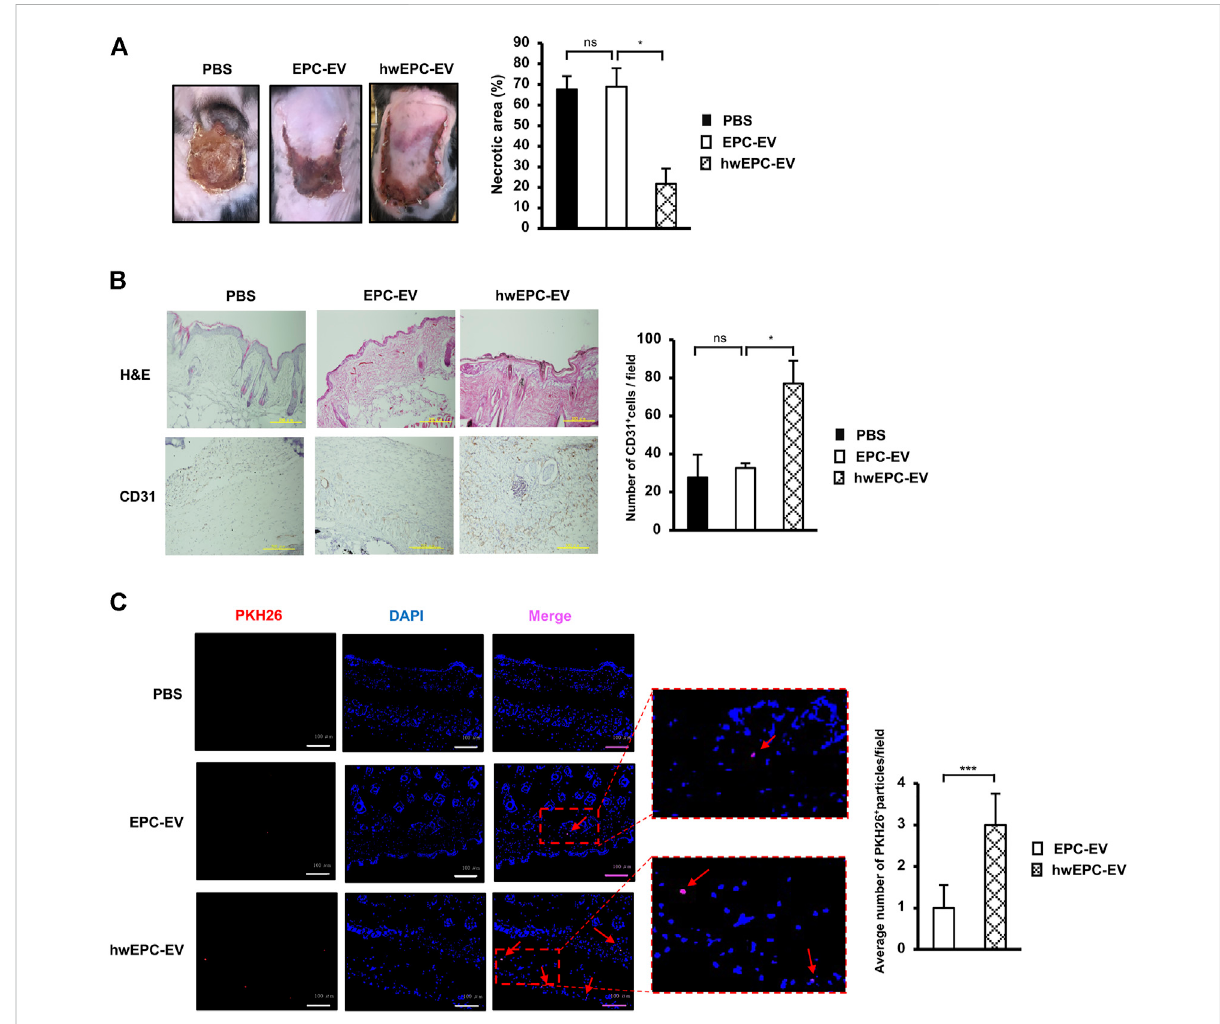
FIGURE 4 hwEPC-EV werehighly uptakenbytheischemictissues andpossessthepromotedfunctionstotreat theischemic tissues (A) .The necrotic area of female ischemic fl ap mice with tail vein injection of EV ( n = 9) (B) . Immunohistochemical staining of CD31 in skin tissue specimens. The photos were captured under a microscope at 10 × magni fi cation. Bars indicate 500 µm (C) . The fl uorescence imaging analysis of PKH26-labeled EV at 24 h after tail vein injection. Photos were captured under a microscope at 20 × magni fi cation. Bars indicate 100 µm ( n = 3). The data represent the mean ± SD. ** p < 0.01, * p < 0.05, ns: no signi fi cance. The experiments were performed in